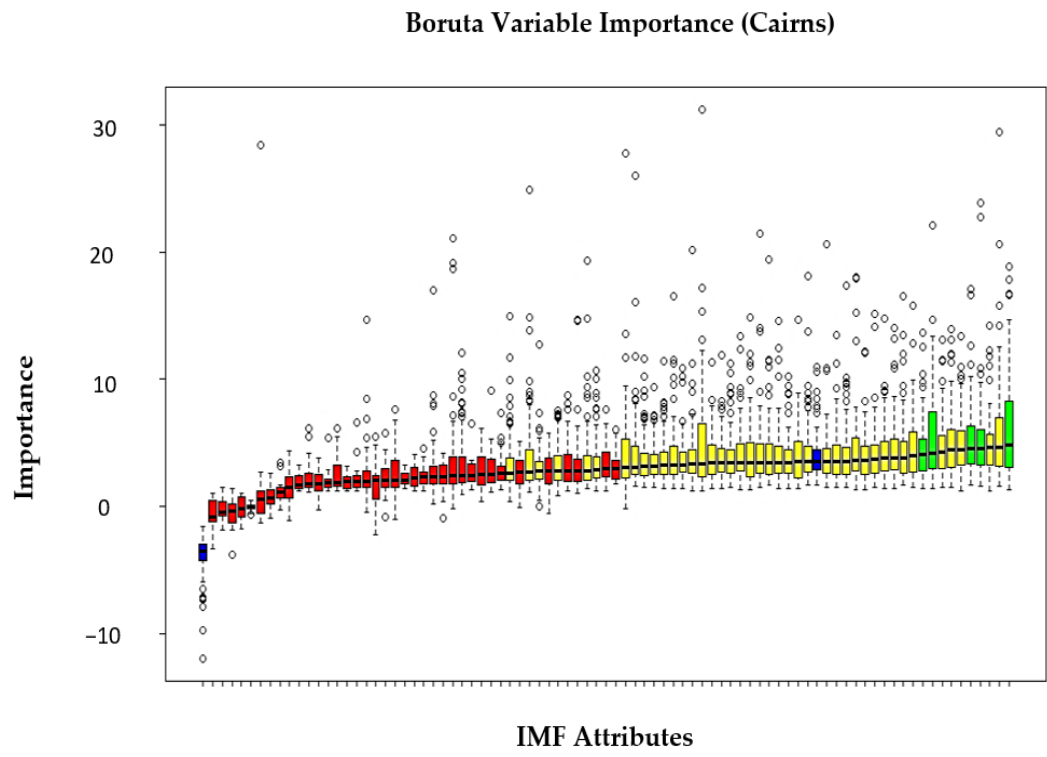
Figure 5. Boruta feature selection output for Cairns. The intrinsic mode functions (IMFs) are compared with shadow attributes and declared as confirmed (hit) or rejected (removed) using the Boruta algorithm in R package.